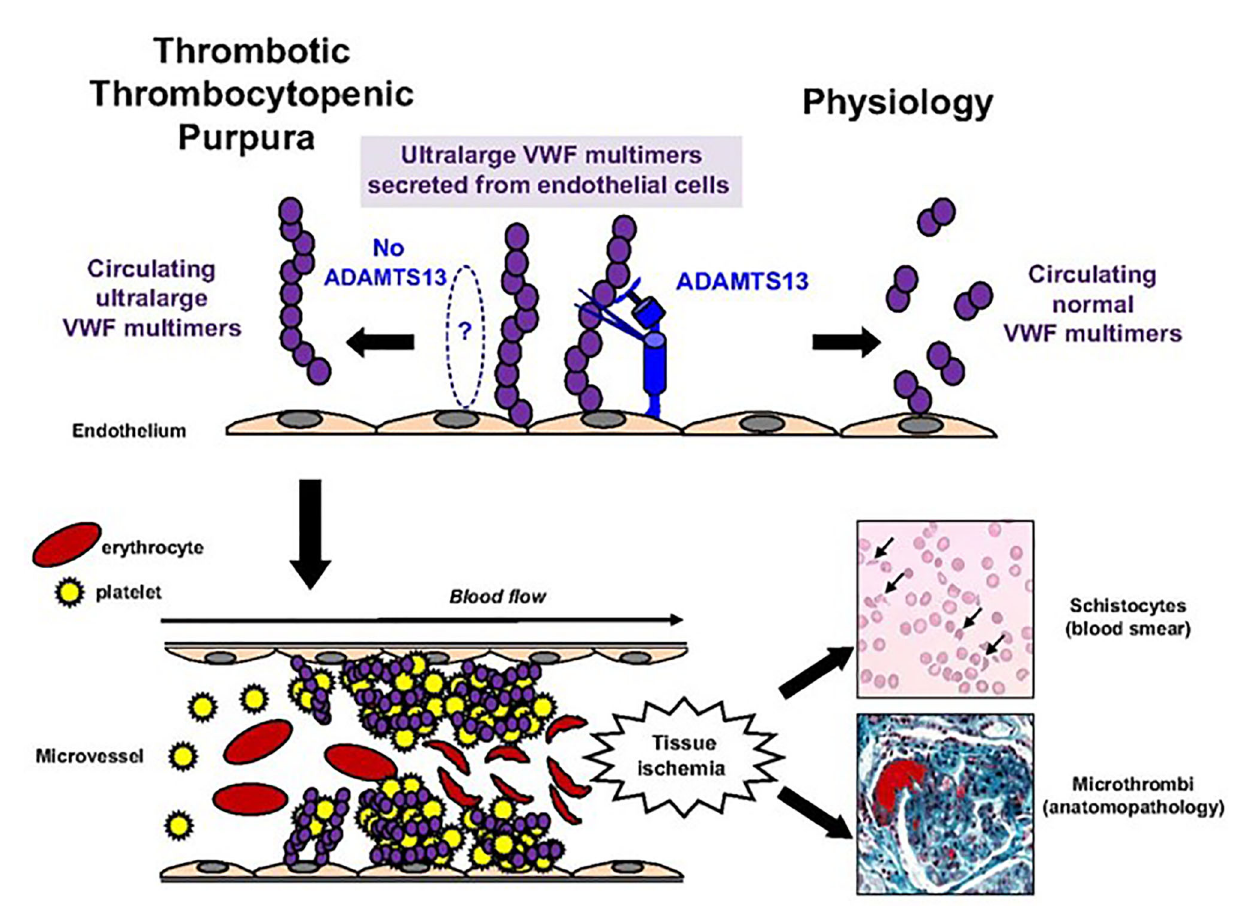
FIGURE 1 | Pathophysiology of TTP. Pathophysiology of TTP. In physiologic conditions, ultralarge VWF multimers released from endothelial cells are cleaved by ADAMTS13 in smaller VWF multimers, less adhesive to platelets. In TTP, because of the absence of functional ADAMTS13 (either absent by congenital defect or inhibited by speci fi c autoantibodies), ultralarge VWF multimers are released into the blood and bind spontaneously to platelets to form aggregates within the arterial and capillary microvessels. The VWF platelet aggregates are large enough to form microthrombi inducing tissue ischemia, platelet consumption, and microangiopathic hemolytic anemia (schistocytes on blood smear).This fi gure was originally published in Blood , and re-printed with permission here. Be ́ rangère S. Joly, Paul Coppo, and Agnès Veyradier. Thrombotic thrombocytopenic purpura. Blood. 2017;129(21):2836-2846. © the American Society of